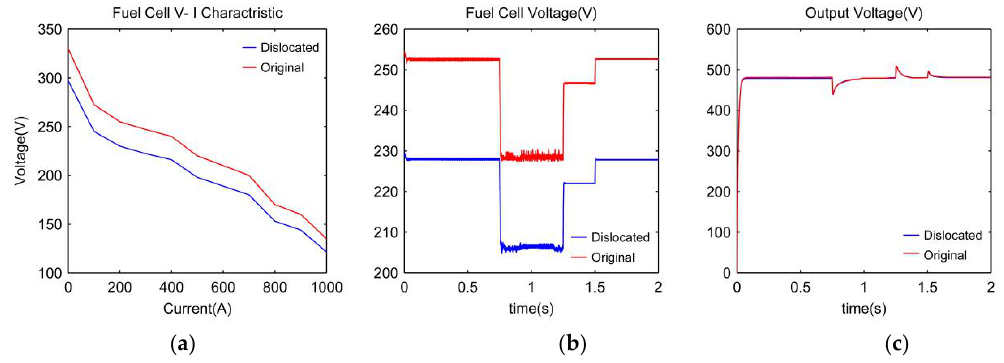
Figure 12. Robustness check of proposed controller ( a ) Changing of V-I characteristic of fuel cell; ( b ) Fuel cell voltage regard changing characteristic; ( c ) Output voltage regard changing characteristic.